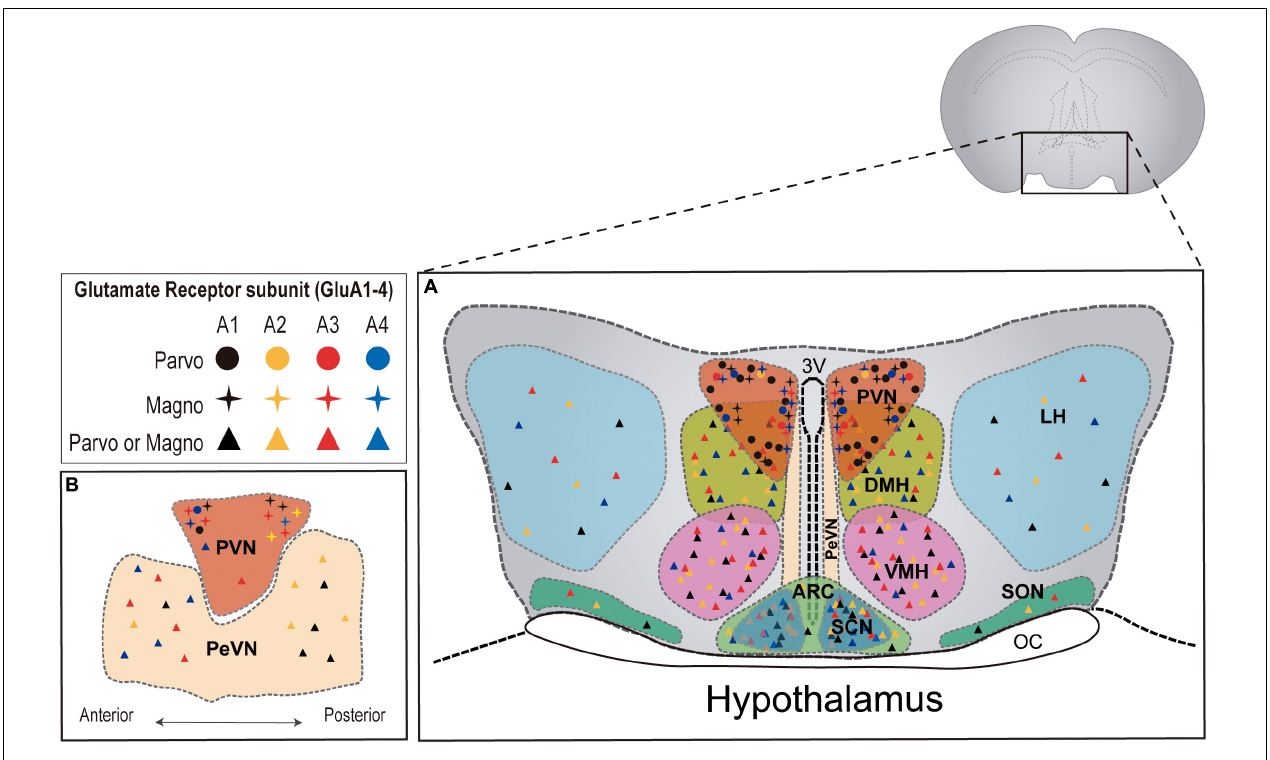
FIGURE 1 | AMPAR subunit distribution across distinct hypothalamic nuclei in the rat brain. (A) Coronal plane of the hypothalamus showing the different hypothalamic regions. PVN = paraventricular nucleus; DMH = dorsomedial hypothalamus; VMH = ventromedial hypothalamus; LH = lateral hypothalamus; SON = supraoptic nucleus; PeVN = periventricular nucleus; SCN = suprachiasmatic nucleus; ARC = arcuate nucleus. (B) Sagittal plane of hypothalamic nuclei. AMPAR subunit abundance is represented for each nucleus according to available literature in the rat brain (Van Den Pol et al., 1994; Eyigor et al., 2001). Detailed information regarding AMPAR subunit abundance in magno and parvocellular neurons is only available for the PVN (Herman et al.,